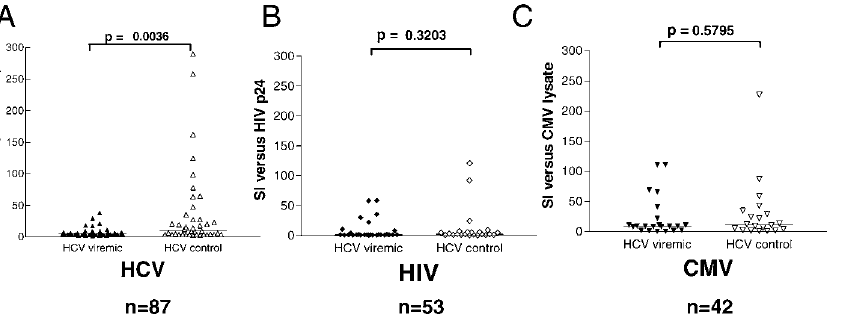
Figure 3. HCV Viremia Is Associated with Decreased Lymphoproliferation against HCV Antigens But Not against HIV or CMV (A) The cumulative SI against HCV antigens core, NS3, NS4, and NS5. Four of 60 coinfected participants and three of 34 monoinfected participants could not be tested due to lack of fresh PBMCs, thus 87 of 94 of the total cohort were tested. (B) Responses against HIV-1 p24 antigen. Of 60 coinfected participants, 53 were tested. (C) Responses against CMV in coinfected participants, including the 42 participants confirmed as seropositive for CMV.